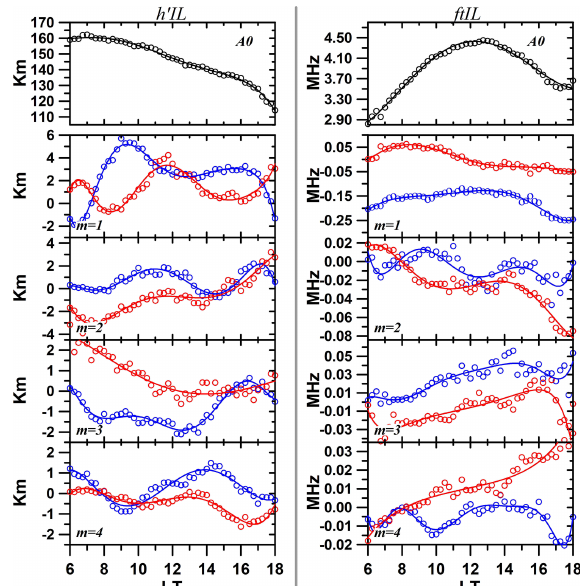
Figure 3. Dependence of the h’IL / ftIL’s FFT coefficients as a func- tion of LT (left or right, respectively). The circles are the values ob- tained by the FFT decomposition, while the continuous lines are the best polynomial approximation. The colors blue and red are used to represent the coefficients values of Am (t) and Bm (t) ,